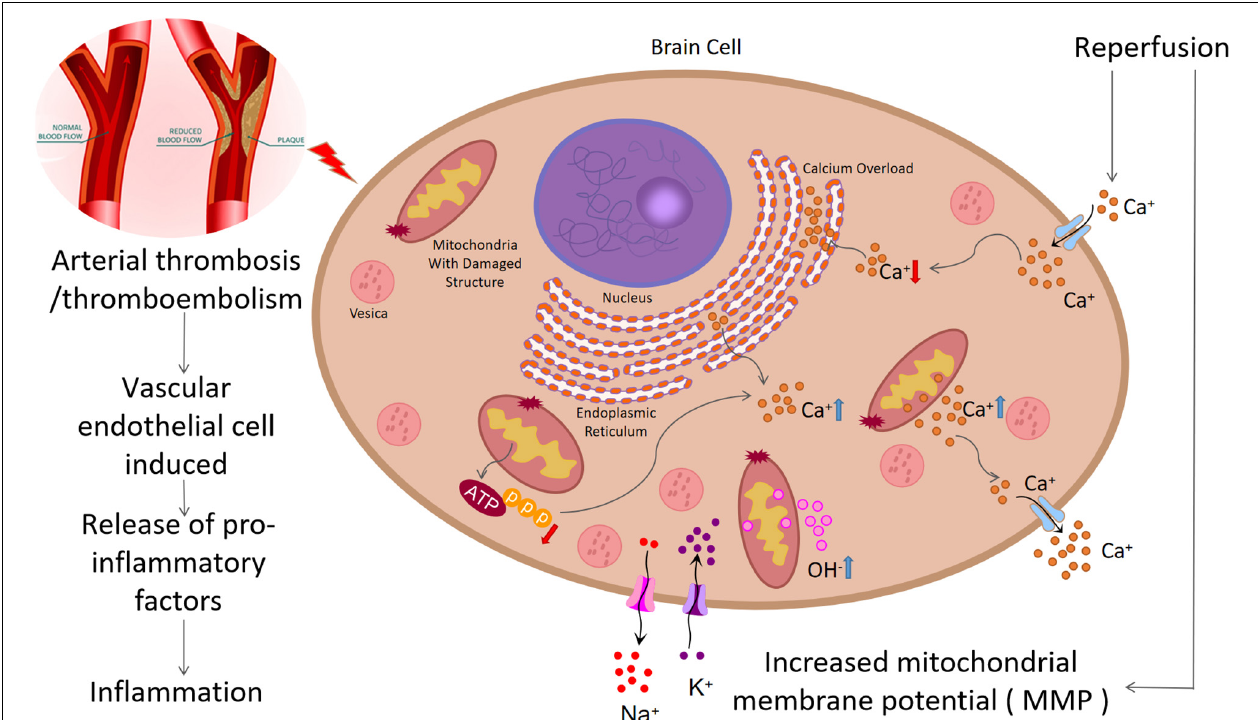
FIGURE 1 | Pathological process of ischemic stroke: (1) Arterial thrombosis or arterial embolism will lead to ischemia and hypoxia of nerve cells, leading to damage of mitochondrial structure and function, decrease of ATP generation, increase of intracellular calcium overload and free radical generation, and aggravation of ischemia and hypoxia. (2) In addition, this process can damage endothelial cells and increase inflammatory response. (3) Mitochondrial structure damage can increase the concentration of OH − , causing oxidative stress. (4) Reperfusion injury can increase mitochondrial membrane potential (MMP), resulting in increased OH − production and increased oxidative